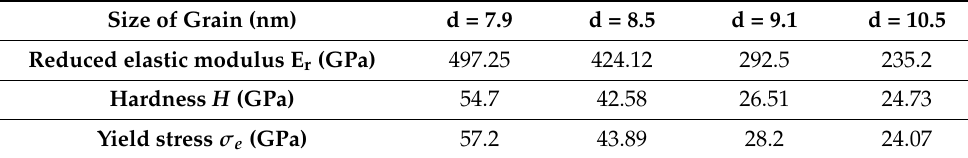
Table 2. Hardness measurements in GPa, for all concentrations. Size of Grain (nm) d =